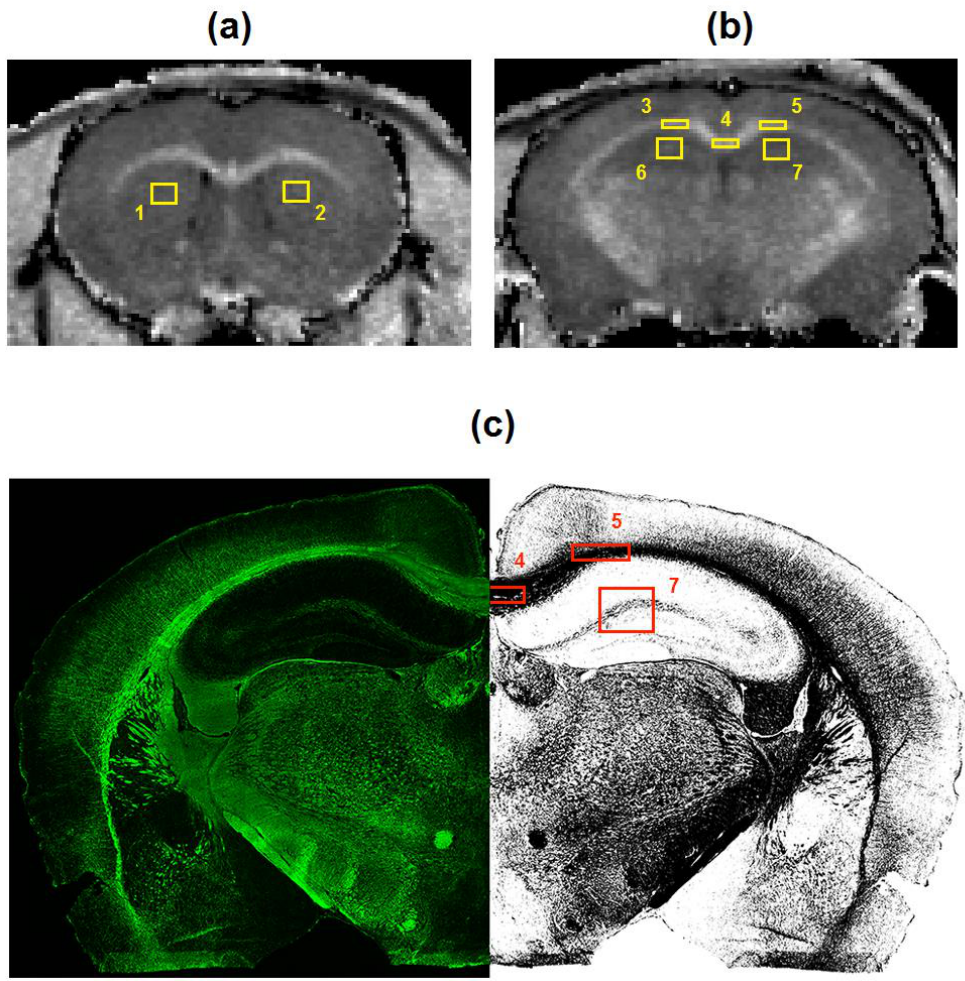
Figure 1. The scheme of image processing for macromolecular proton fraction (MPF) maps ( a,b ) and myelin basic protein (MBP)-stained images ( c ). Cross-sections of a 3D MPF map of a control mouse taken at the locations of + 0.74 mm (a) and − 1.58 mm (b) from bregma and superimposed with regions-